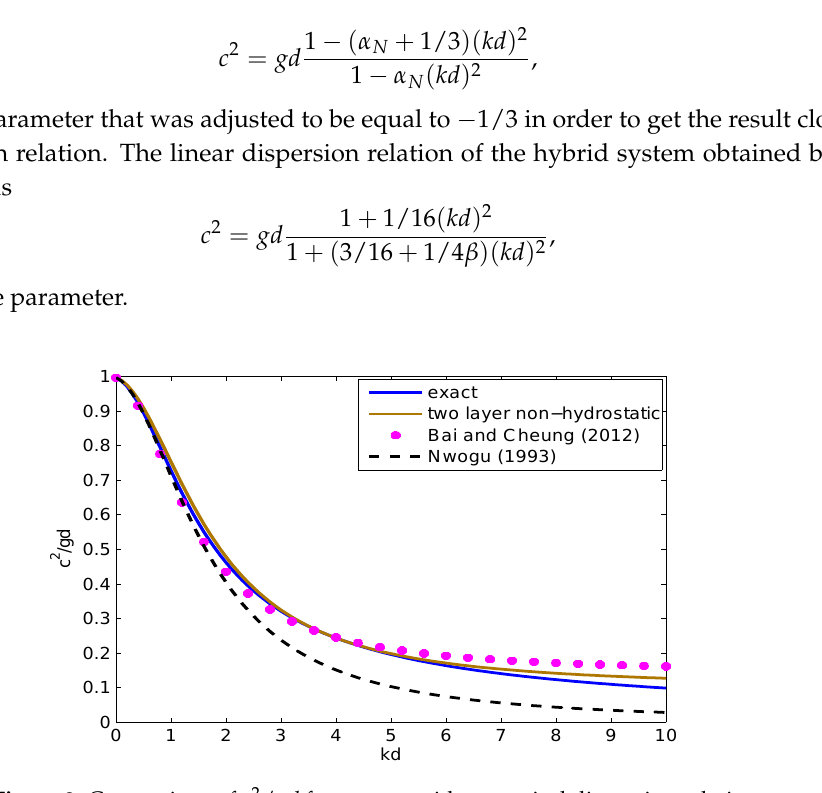
Figure 2. Comparison of c 2 / gd from exact with numerical dispersion